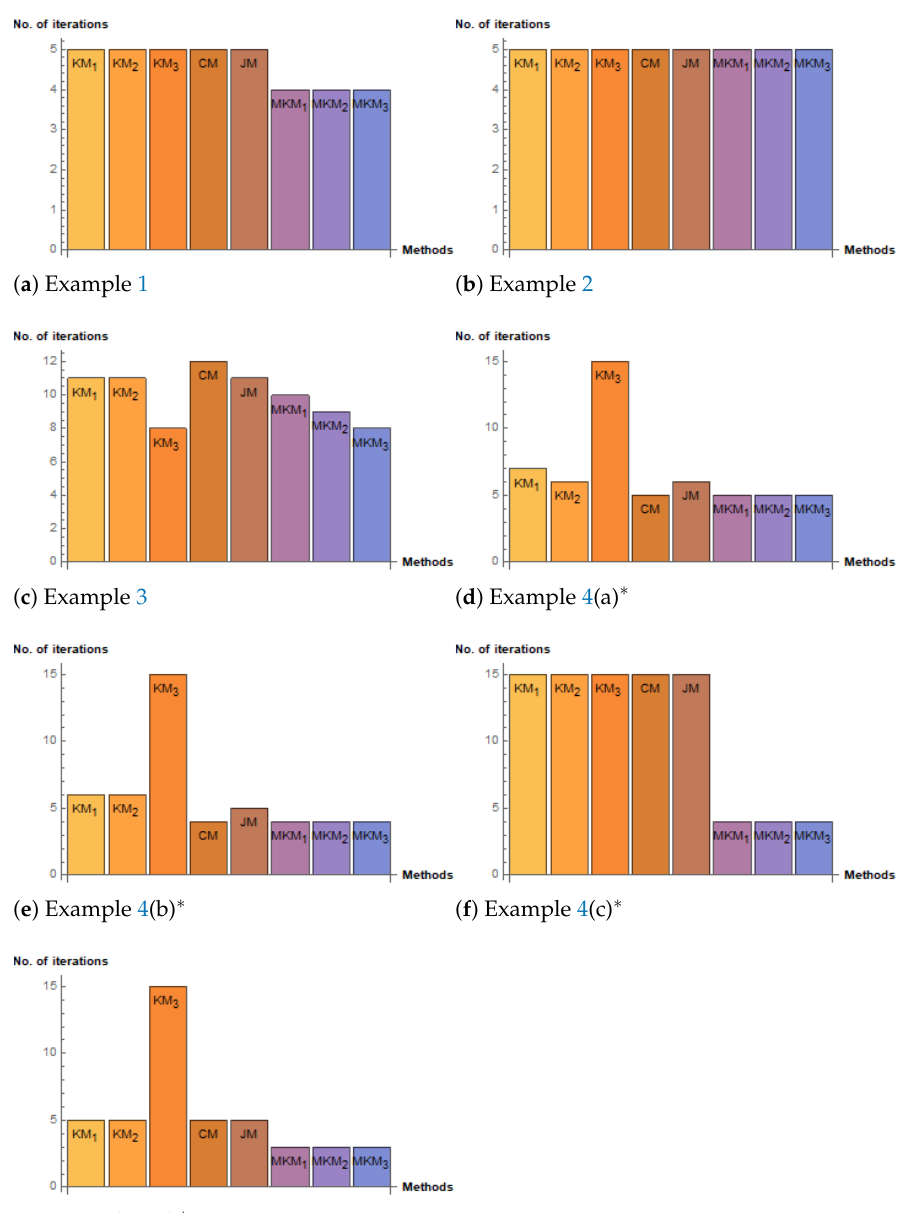
Figure 2. Bar graph on the basis of the number of iterations. * Note that in these figures, bars for 15 iterations does not means convergent. It is a case of